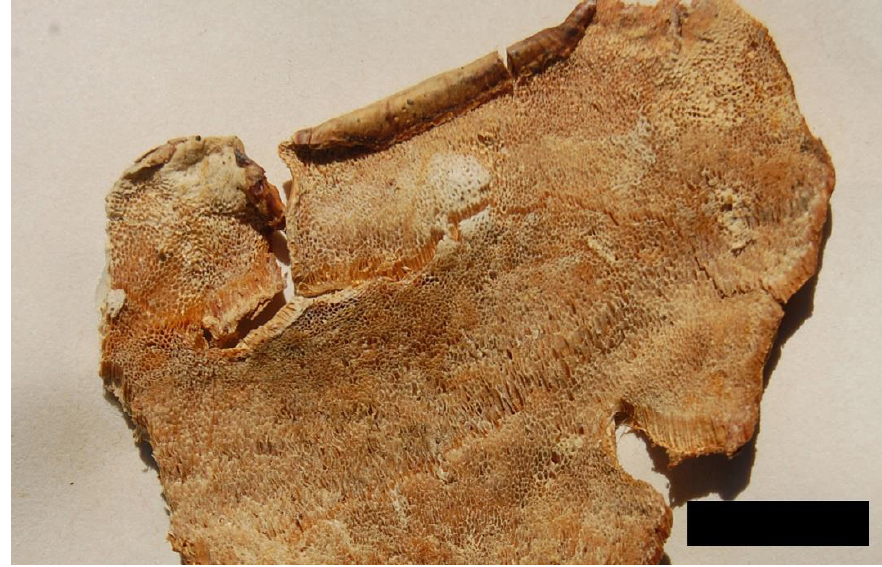
Figure 3 . Basidiomata of Poriella subacida ( Holotype, BPI 844697 ). Scale bar = 1 cm .